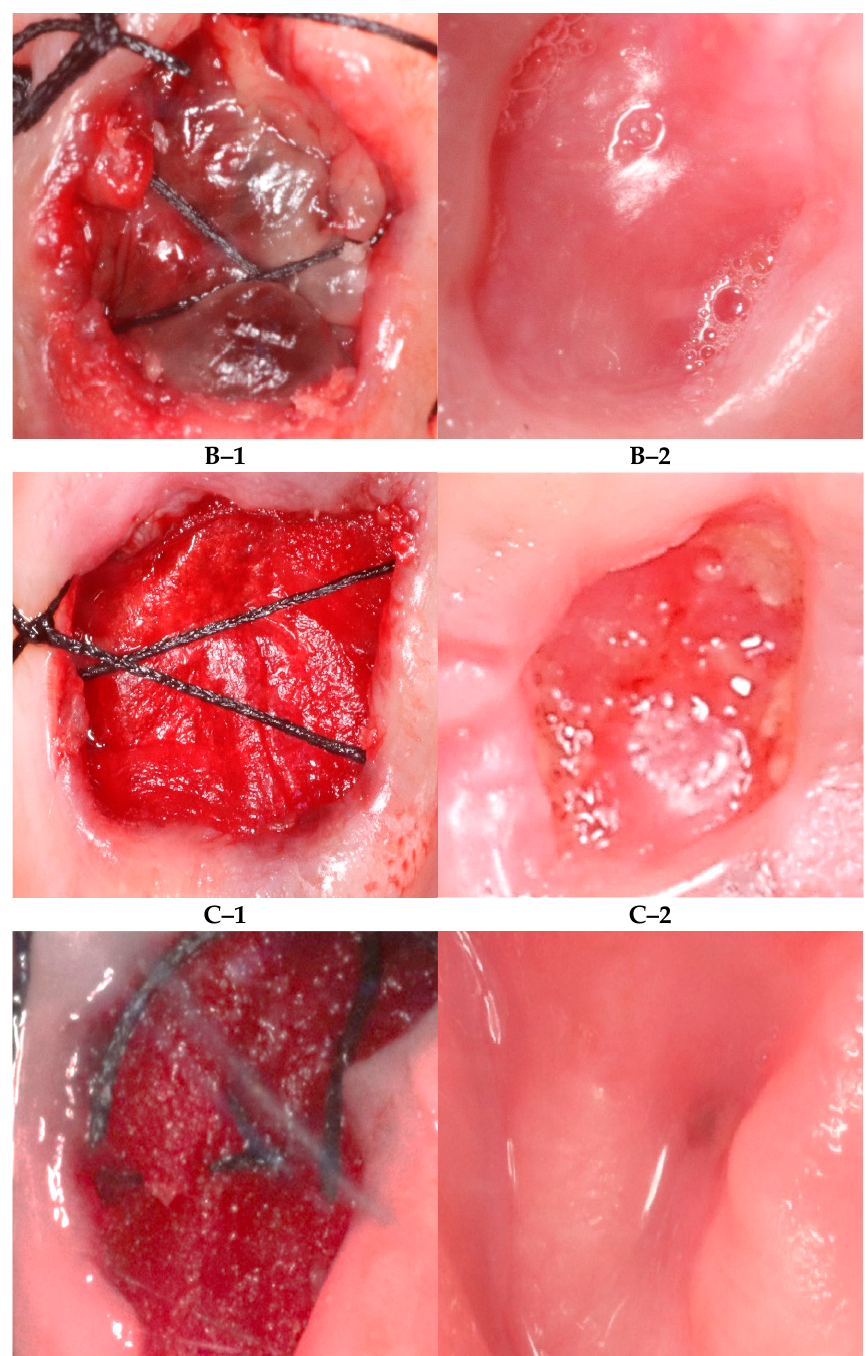
Figure 1. Clinical photos for surgical procedure. ( A–1 ) Extraction with A-PRF at baseline ( A–2 )